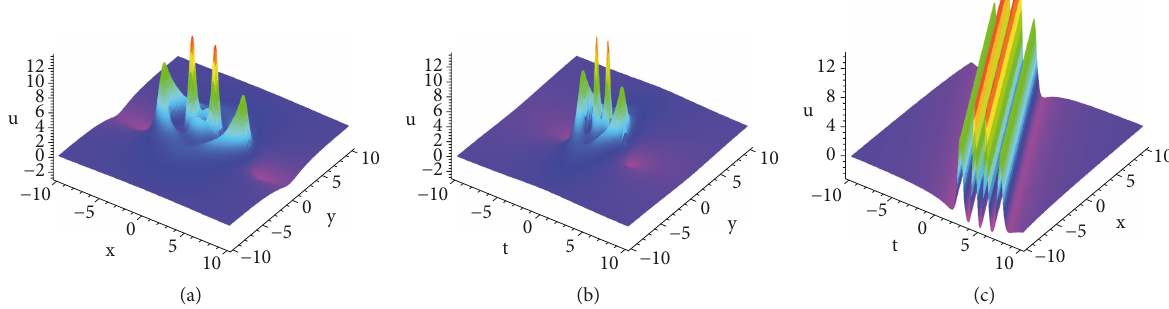
Figure 4: Plots (colored online) of rogue wave 𝑢 4 with 𝑚 = 2,𝑎 = 𝑏 = −2 . (a) Perspective view of the wave 𝑢(𝑥,𝑦, 0) , (b) perspective view of the wave 𝑢(0, 𝑦, 𝑡) , and (c) perspective view of the wave 𝑢(𝑥, 0,𝑡)